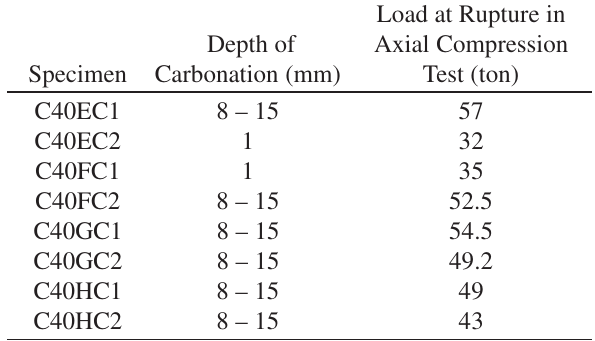
Table 5. Mechanical Properties of Concrete After Carbonation